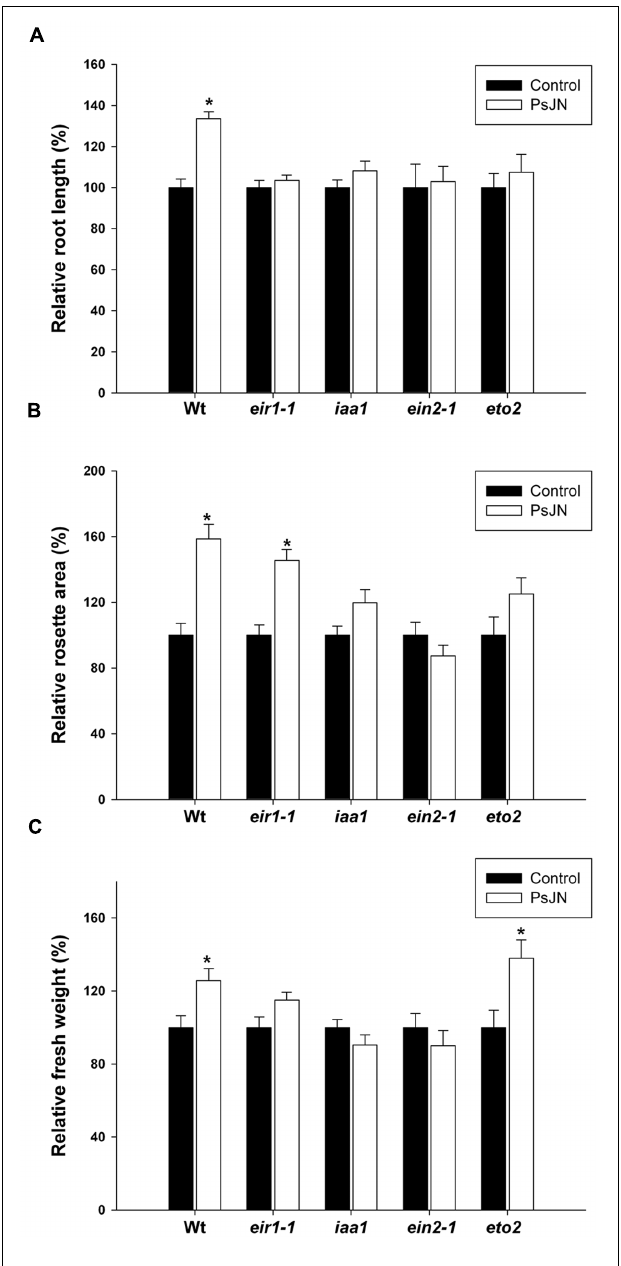
FIGURE 6 | Effects of B. phytofirmans PsJN in different Arabidopsis mutants associated to auxin and ethylene pathways. Relative primary root length (A) , rosette area (B) and fresh weight (C) in 14 days old wild type (wt) or mutant plants inoculated (PsJN) or not (control) with strain PsJN. Arabidopsis mutants lines used were eir1–1 (CS8058), iaa1 (CS16234), ein2-1 (CS3071), and eto2 (CS8059). Data are means ± SE of 17–35 plants per treatment, and represent at least four independent experiments. Asterisk indicates statistical significance between the inoculated and non-inoculated plants in each genotype (One way ANOVA, p <